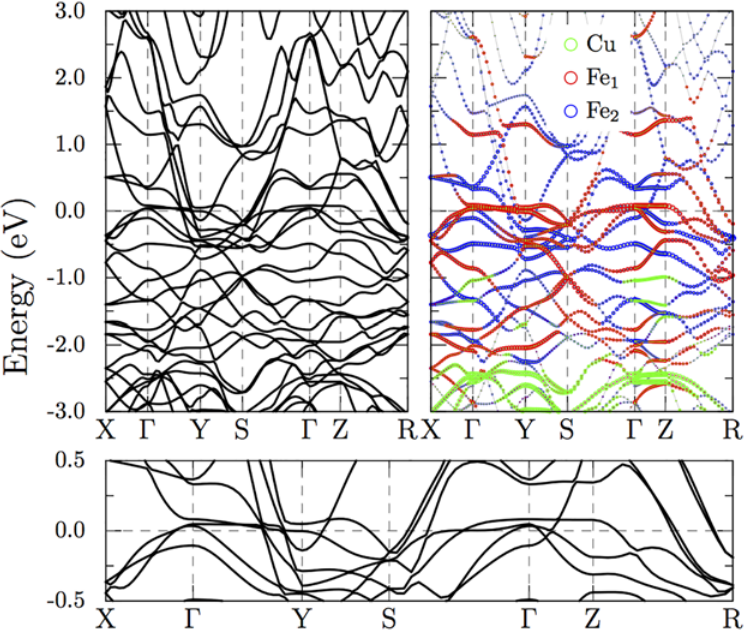
Fig 3. Electronic band structure of CuFe 2 Ge 2 in the non-magnetic phase calculated using GGA. The bottom panel zooms in on the states close to Fermi level which is set to 0 eV. The orbital character of the bands are shown by colored symbols in the top right panel. States close to Fermi level are dominated by Fe- 3 d states.